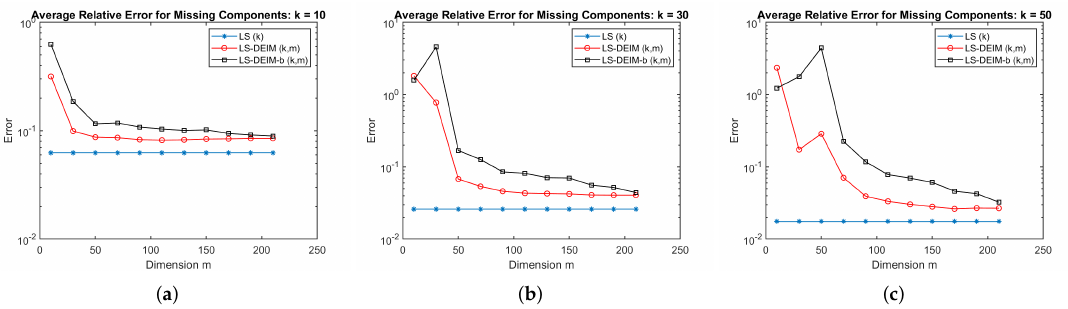
Figure 6. (Numerical Test 2) Average relative error of the reconstructed missing components using the standard POD-LS method and the accelerated POD-LS method, denoted by LS-DEIM for case (i) and LS-DEIM-b for case (ii) defined in Algorithm 4 for POD dimension k = 10,30,50 are shown in ( a – c ), respectively, with DEIM dimension m = 10,30,50, . . . ,210. Table 1. (Numerical Test 2) The average relative error of the reconstructed missing data and the corresponding scaled CPU times for the reconstruction when the standard POD-LS method and the accelerated POD-LS method with rSVD are used. Dimensions for POD: k = 10, DEIM: m = 10,20,50. Method dim POD dim